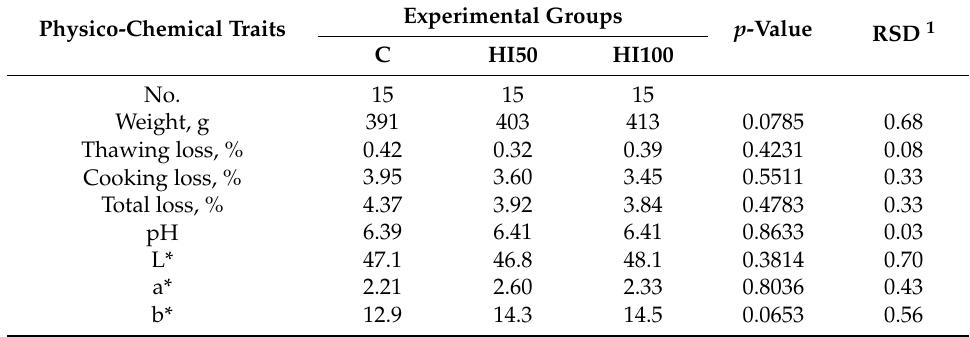
Table 3. Physico-chemical quality of the leg meat of chickens fed with 0% (C), 50% (HI50) and 100% (HI100) substitution of soybean oil with Hermetia illucens (HI) larvae fat in their finisher diets. Physico-Chemical Traits